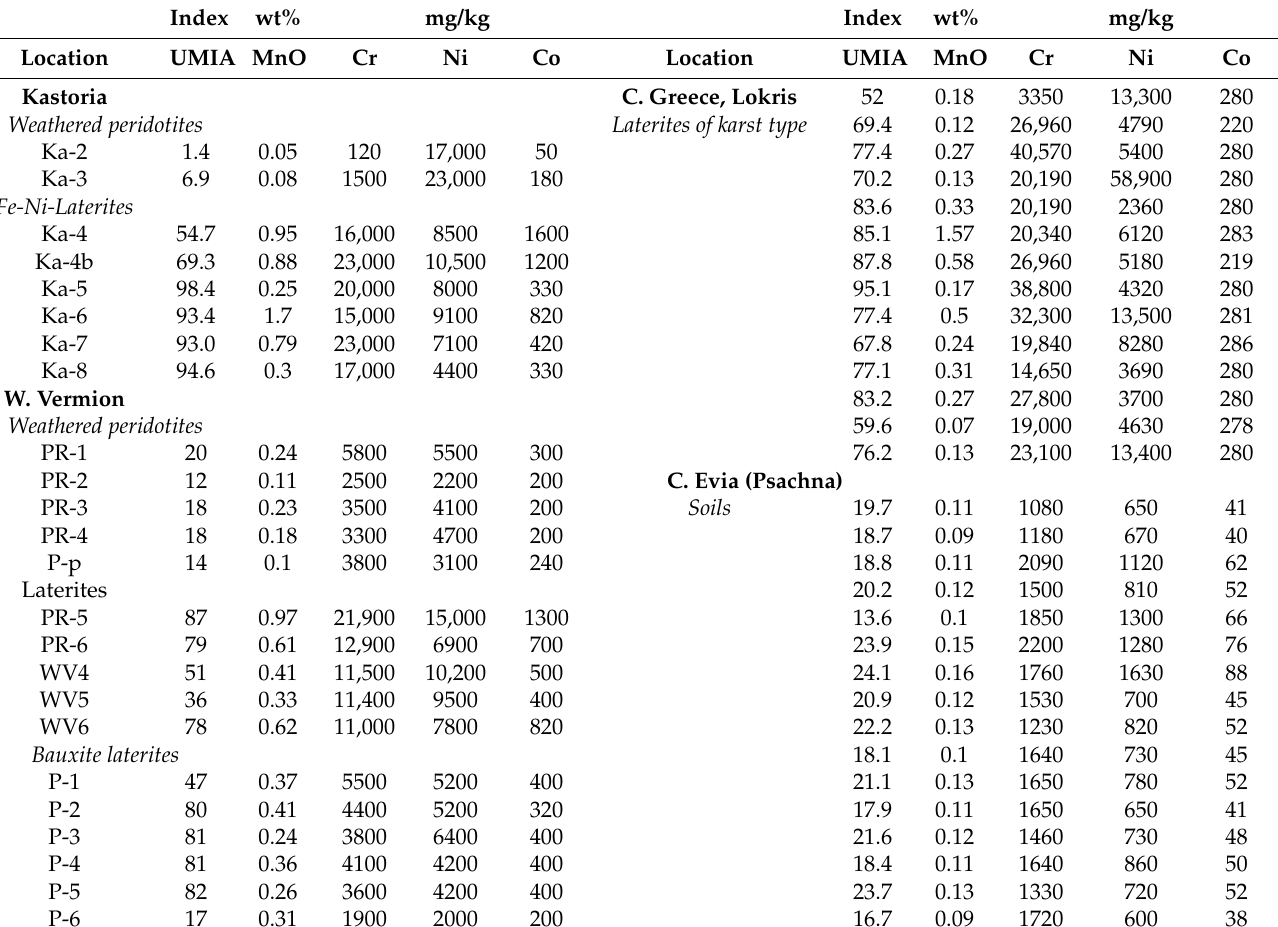
Table 1. Calculated Ultramafic Index of Alteration (UMIA) for representative samples of weathered peridotites Fe–Ni- laterites, bauxite laterites, and contaminated soils from Greece. Data from